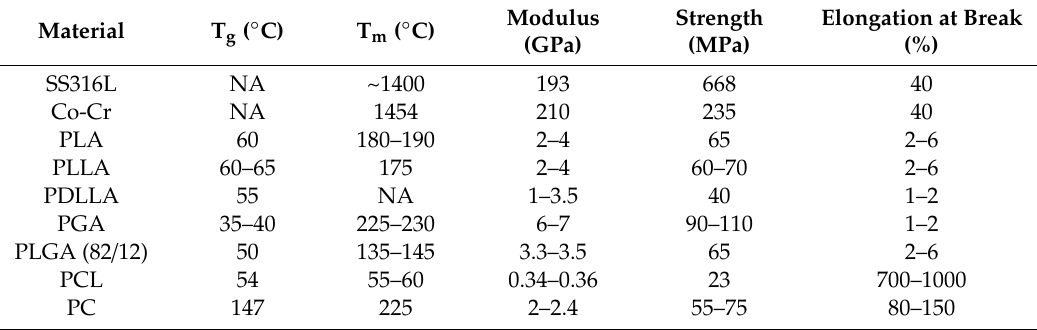
Table 1. Physical and mechanical properties of polymeric BRS materials